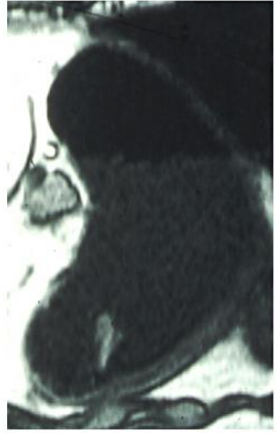
Figure 2. Oil-filled capsule disintegrating in the stomach.